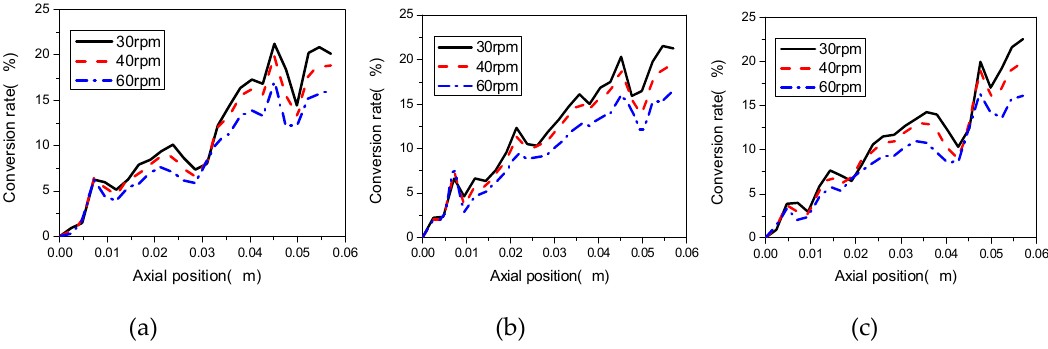
Figure 10. Effect of screw speeds on conversion rate at ( a ) Line 1; ( b ) Line 2; ( c ) Line 3 in the TSE.